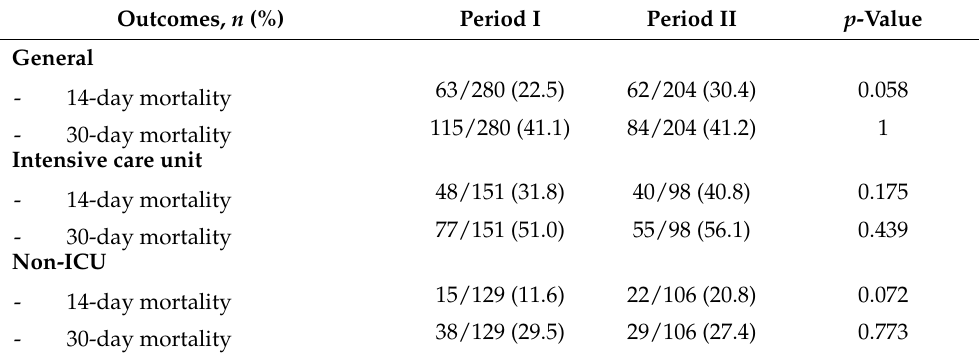
Table 6. Clinical outcomes of adults with candidemia diagnosed at tertiary hospitals in Brazil during Period I: 2010–2011 vs. Period II: 2017–2018 * who received antifungal